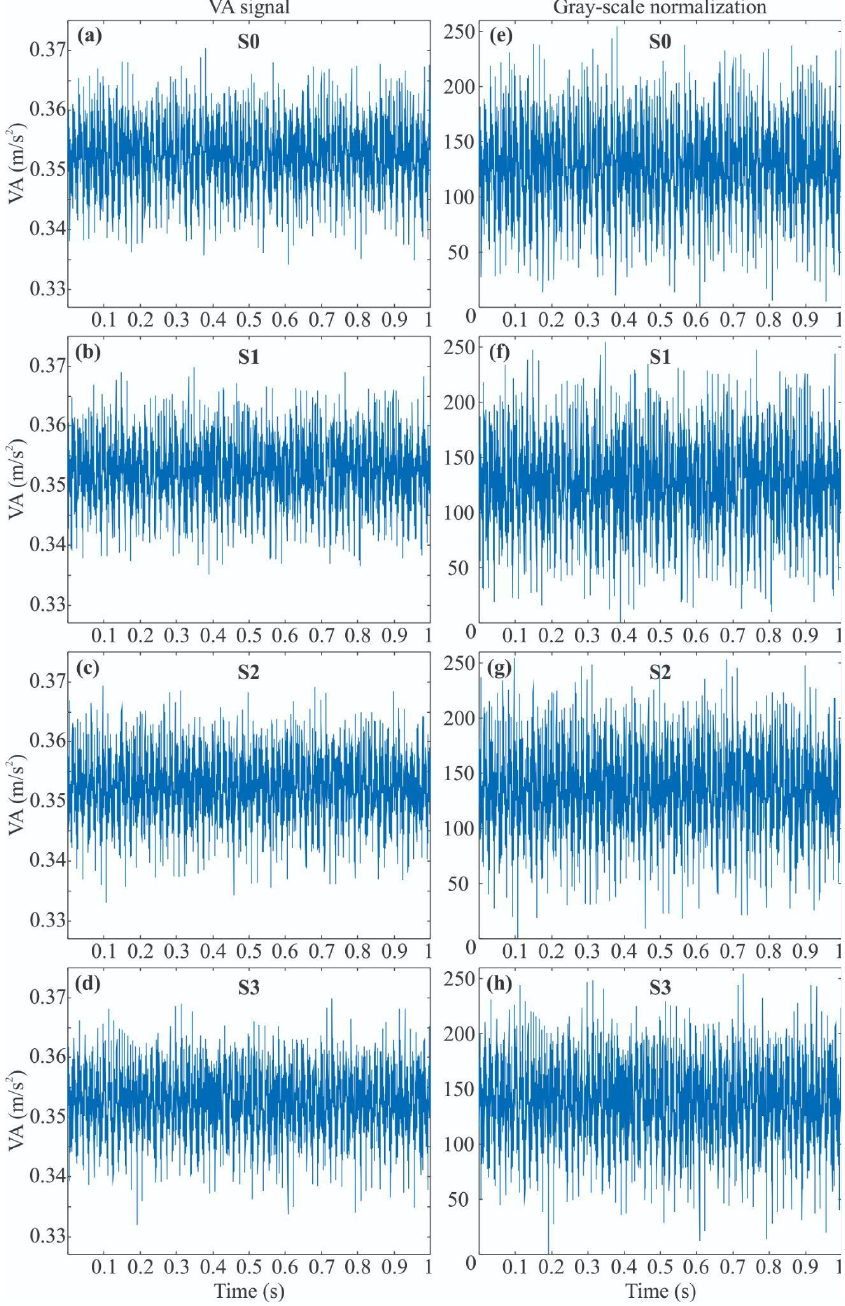
Figure 5. Example of a VA acquired signal and its gray-scale normalization: ( a ) section S0, ( b ) section S1, ( c ) section S2, ( d ) section S3, and gray-scale normalization for sections ( e ) S0, ( f ) S1, ( g ) S2, and ( h ) S3.